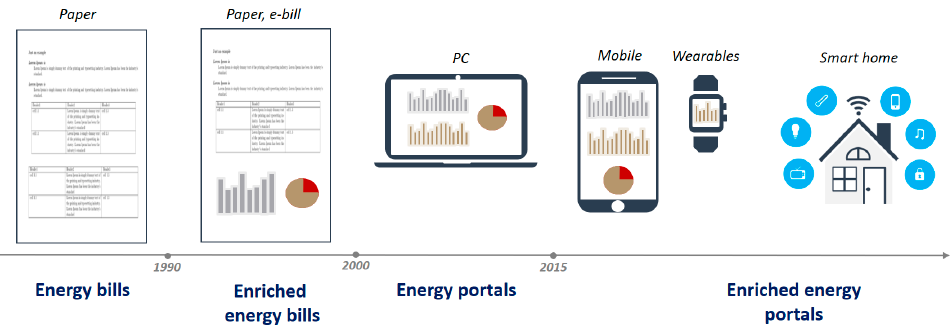
Figure 1. Evolution of communication between utilities and consumers.